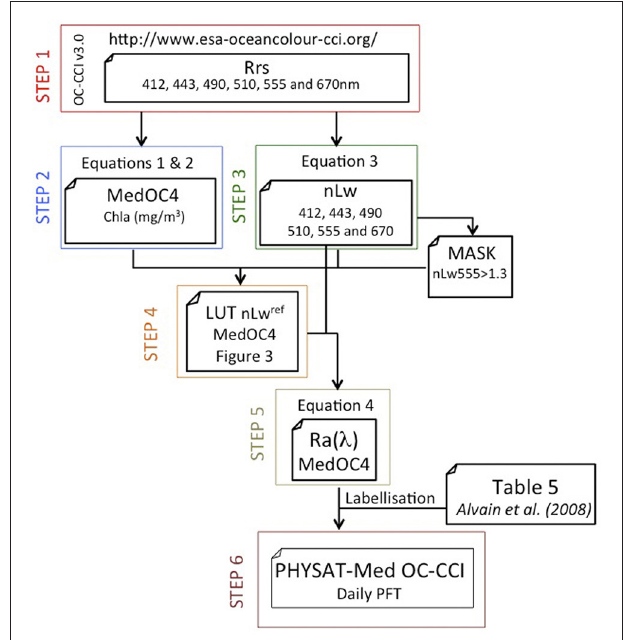
FIGURE 2 | Schematic view of steps of the PHYSAT-Med OC-CCI